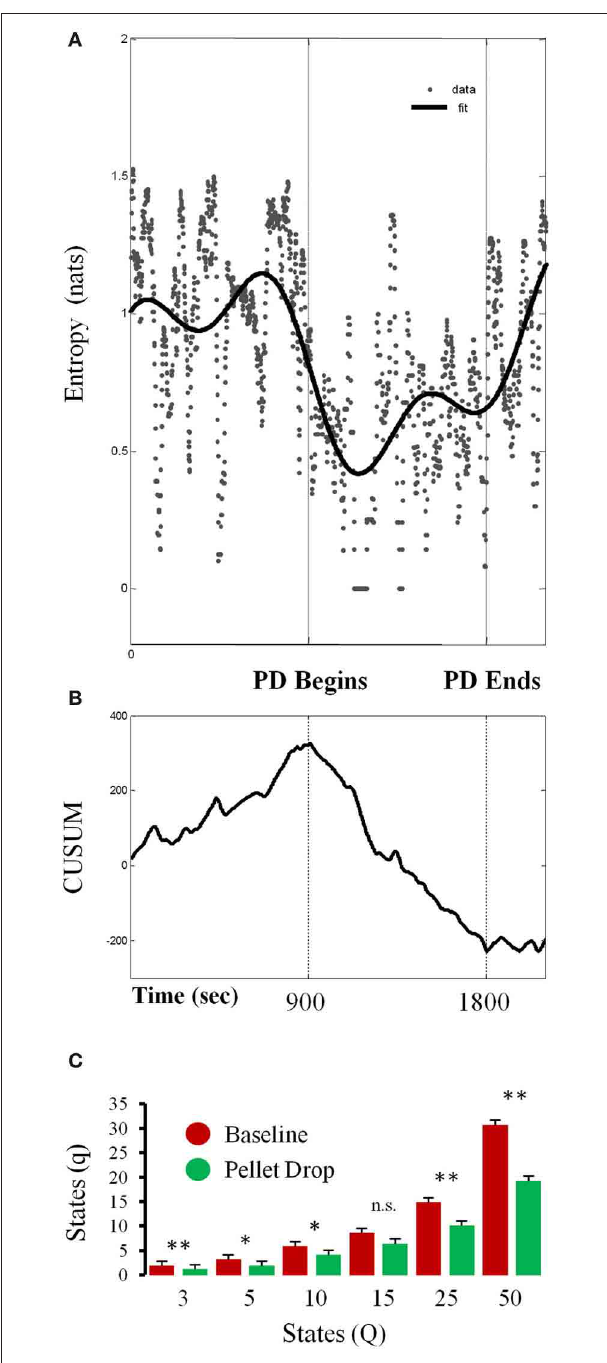
FIGURE 7 | Changes in neural complexity throughoutpellet drop sessions. (A) All neurons from all sessions were pooled and Kolmogorov complexity (KC) was calculated over time using a sliding window of size = 150s. The KC decreased at the point the pellets began to fall (first red line) and increased when they stopped falling (second red line). (B) A principle component analysis (PCA) was calculated on all neurons pooled from all sessions. The average number of principle components (PCs) needed to reconstruct 90% of the iFR decreased as soon as pellets started to fall (first red line) and increased again after they stopped falling (second red